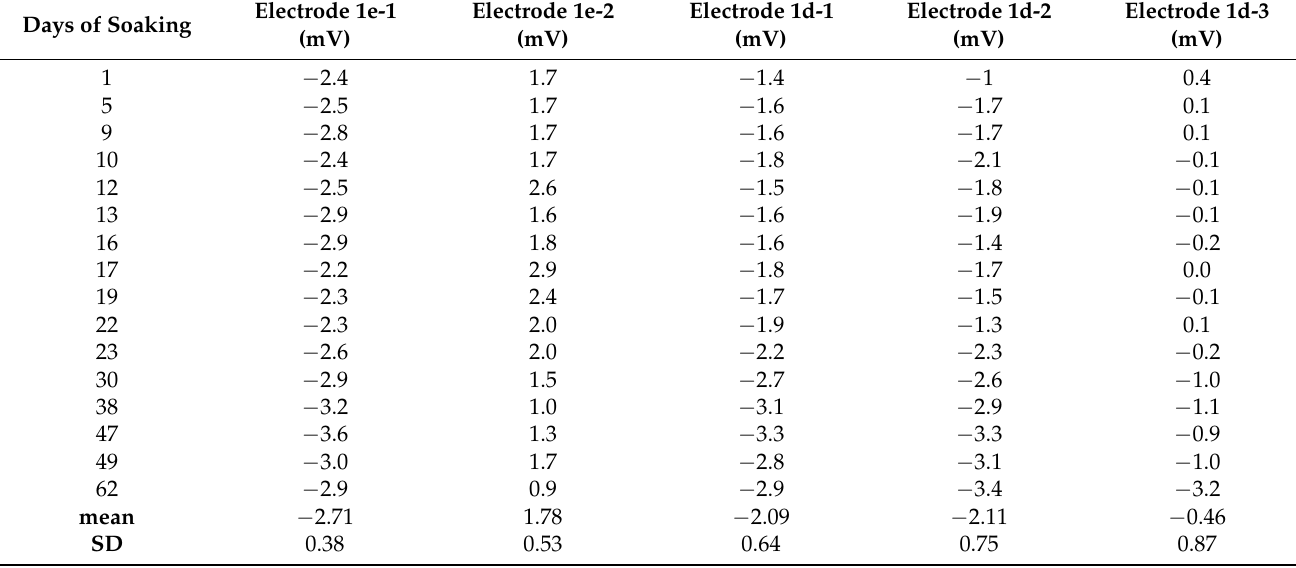
Table 1. Potential of the electrodes 1d and 1e recorded during continuous contact with 0.1 M KCl solution.